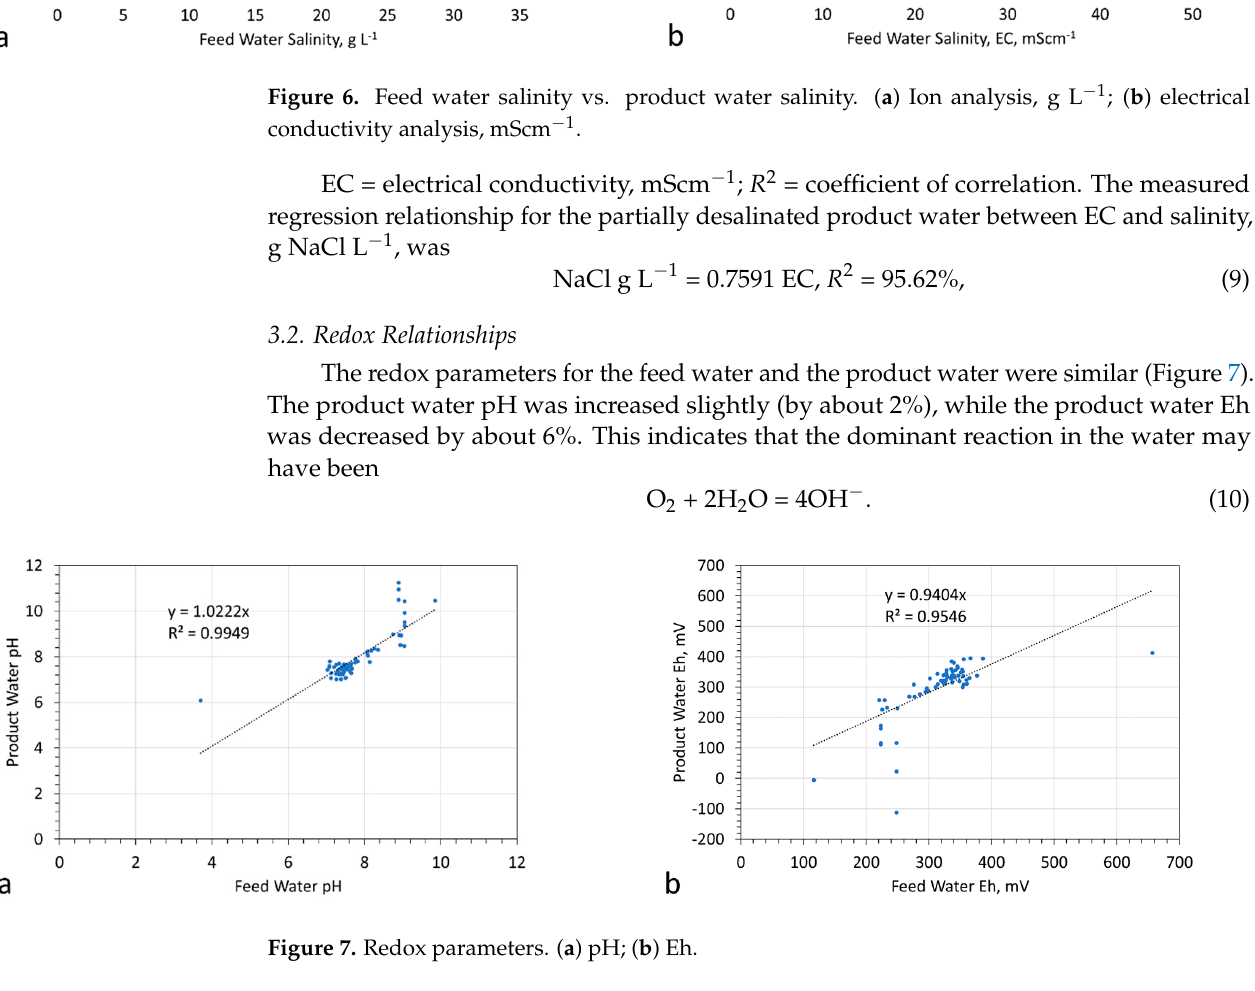
Figure 8. Ion concentrations in the feed water and product water. ( a ) Sodium; ( b ) chloride. 4. Discussion 4.1. Desalination The feed water contains a higher ion concentration than the product water (Table 1, Figures 6 and 8). This indicates that desalination occurred. At the end of 70 trials, there was no noticeable evidence that the amount of desalination in each successive trial de ‐ creased with time (Figure 9). The amount of desalination that occurred was independent of the feed water salinity (when the water contained <10 g NaCl L − 1 ) or showed a weak trend of increasing desalination with increasing feed water salinity (when the water con ‐ tained >15 g NaCl L − 1 ) (Figures 6 and 9). Table 1. Statistical parameters. F w = feed water; P w = product water. T = temperature; SD = standard deviation; Min = minimum; Max = maximum; 1st = first quartile; 3rd Q = third quartile. Dataset: Appendix B Table A1. F w